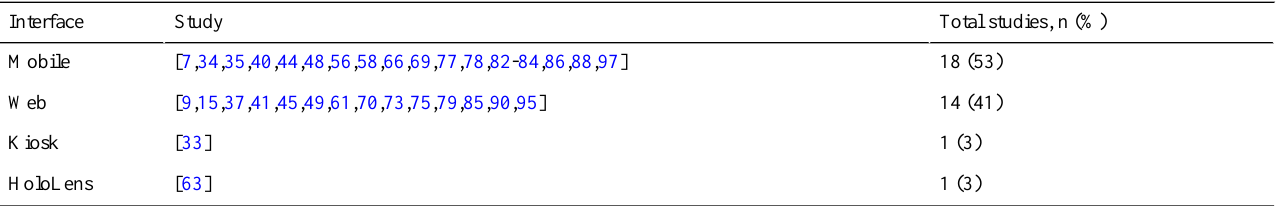
Table 3. Distribution of the interfaces used among the different health recommender systems (n=34).